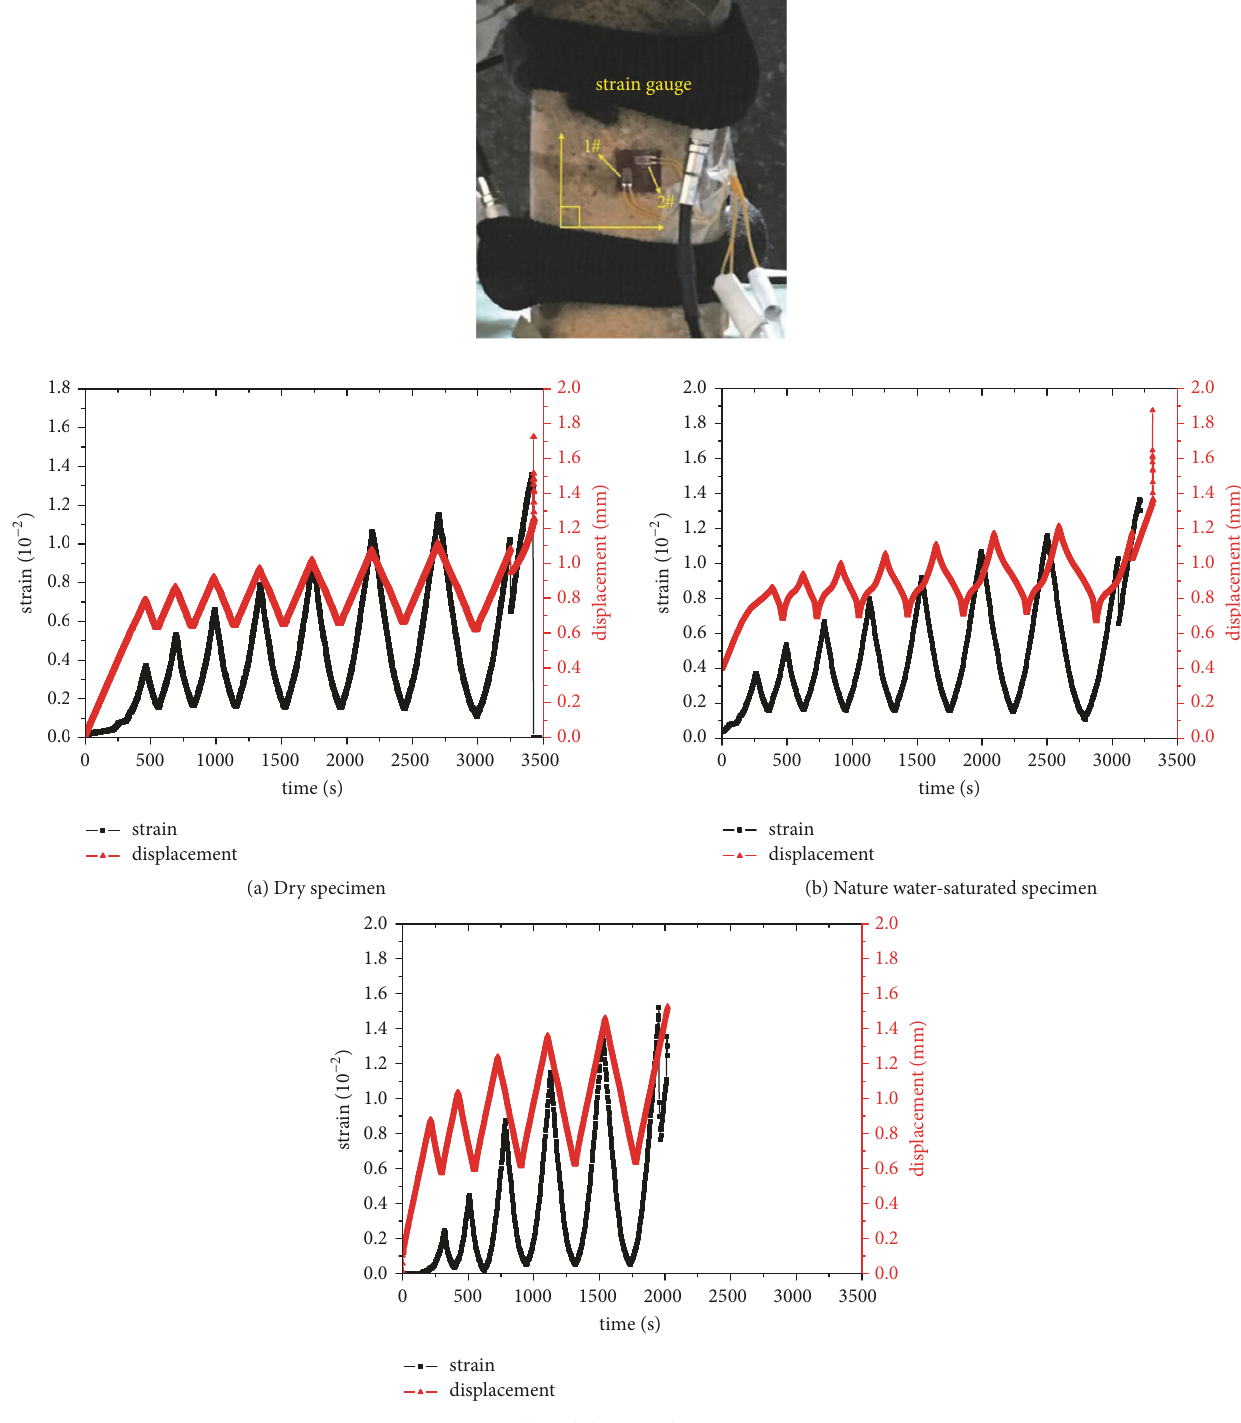
Figure 8: Direction and location of strain gauge. Strain data and loading and unloading displacement of different water content specimens with